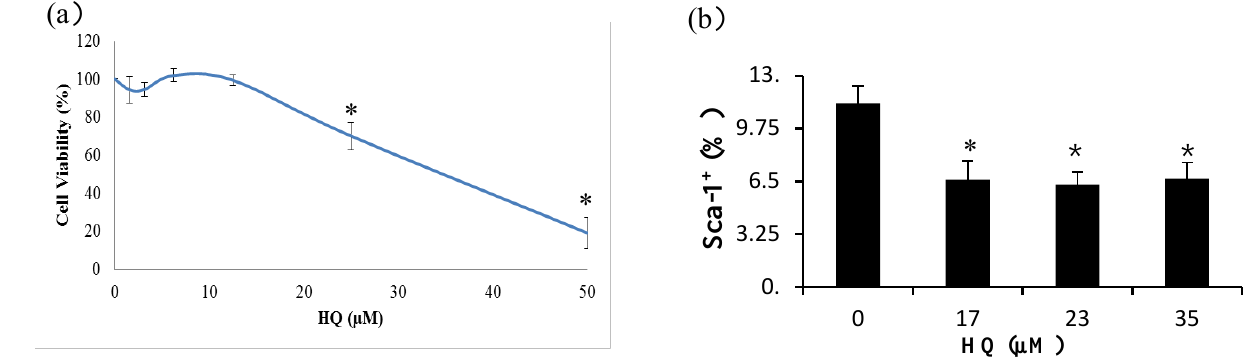
Figure 2 (a) Cytotoxicity of HQ targeting bone marrow cells as determined by the MTT assay. Cells were exposed to HQ at a series of concentrations ranging from 0 to 50 µM for 24 h. (b) Cytotoxicity of HQ targeting hematopoietic stem cells population (Sca-1 + ) as confirmed using immunophenotyping analysis by flow cytometer. Cells were exposed to HQ at a series of concentrations at 0, IC 10 (17 µM), IC 25 (23 µM) and IC 50 (35 µM) for 24 h. Data are presented as the mean ± S.E.M. (n=3). * p < 0.05 as compared to non-treated control group. 3.2 Effect of HQ exposure on clonogenicity of myeloid-committed progenitors As shown in the Figure 3, exposure to HQ for 24 hours at respective concentrations inhibit clonogenicity of myeloid progenitors as evidenced by absent of CFUs formation at 12.5 µM (IC 50 ), and significant (p < 0.05) reduction in CFUs counts at 6.25 µM exposure as compared to control.